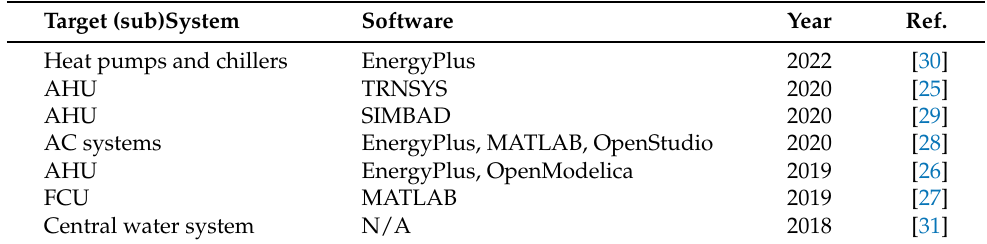
Table 1. Brief summary of related work addressing the physics-based approach in HVAC FDD. For clarity, all acronyms are provided in the Abbreviations